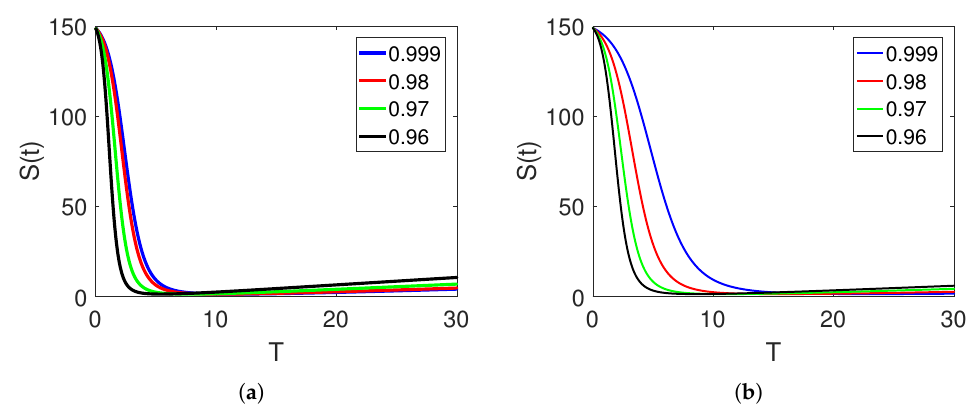
Figure 13. Comparison of Newton polynomial ( a ) and LADM ( b ) for first class on different arbitrary fractional order.